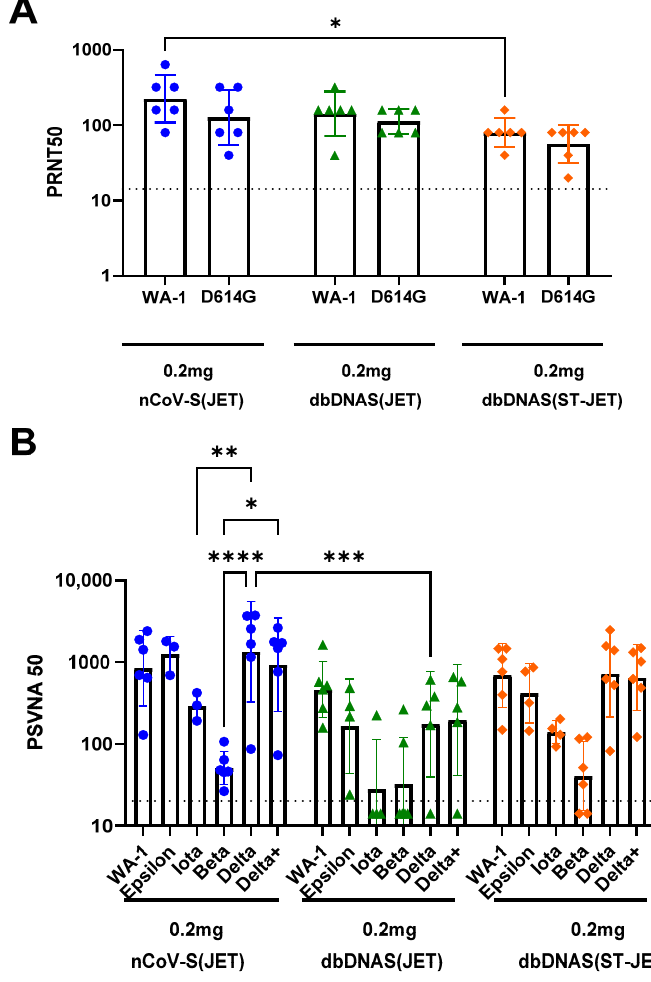
Figure 5. Cross-variant neutralization of serum from hamsters vaccinated with plasmid or Doggybone DNA vaccines. ( A ) Prechallenge serum from hamsters that received two 0.2 mg vaccinations of nCoV-S(JET), dbDNAS(JET), or dbDNAS(ST-JET) was used to perform Washington-1 (WA-1) and D614G variant live-virus PRNT. ( B ) Prechallenge sera were evaluated using Epsilon, Iota, Beta, Delta, and Delta+ pseudovirion neutralization assays. Individual animal titers (symbols) as well as geometric mean and standard deviations are shown for each group. Statistical significance (**** p < 0.0001; *** p < 0.001; ** p < 0.01; * p < 0.05) between variants and within vaccine groups, and same variants between vaccine groups are also shown. An imputed value [25] of 14.1 was used for samples with titers below the assay limit of 20 (dotted line).